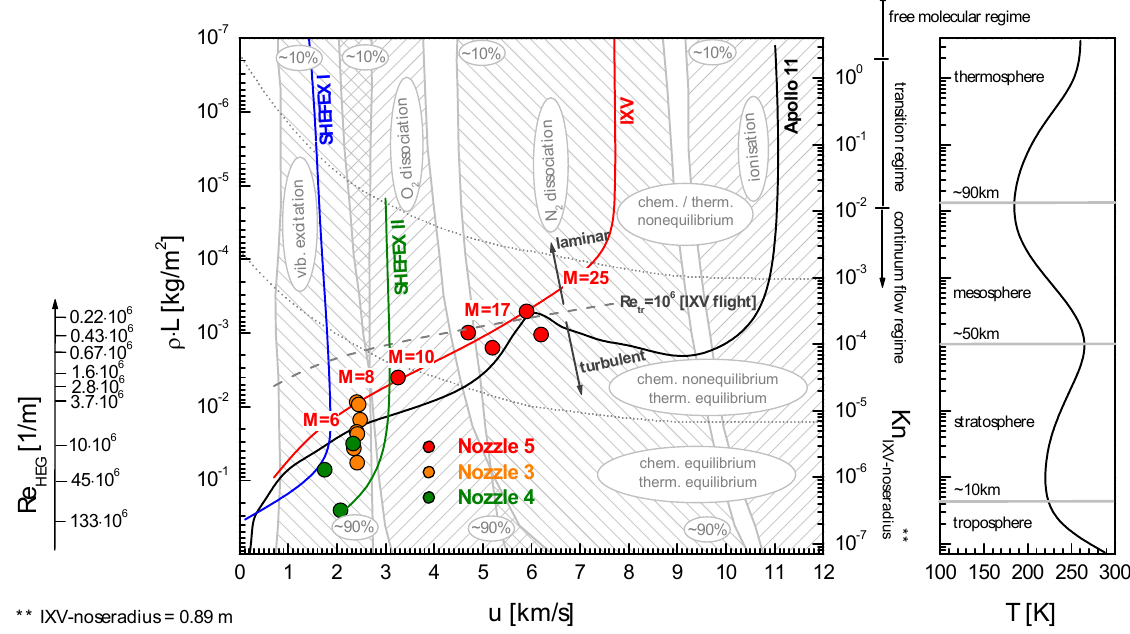
Figure 4: HEG operating range in terms of the binary scaling parameter ρL and the flow velocity